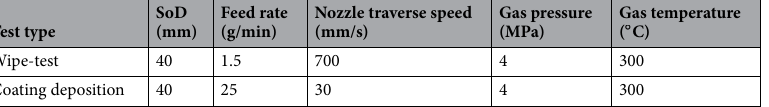
Table 1. Cold spray processing parameters for single-particle impact (wipe-test) and coating build-up experiments.